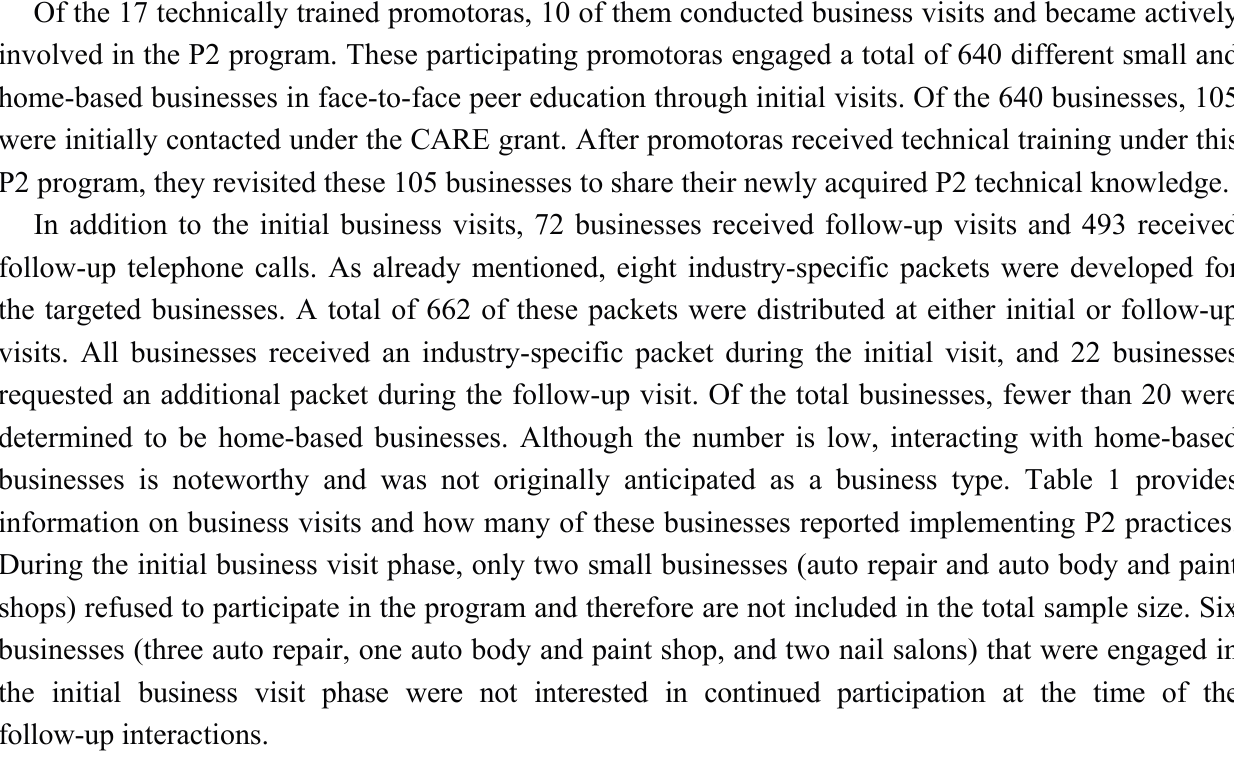
Table 1. Participating businesses in the promotora-led P2 program